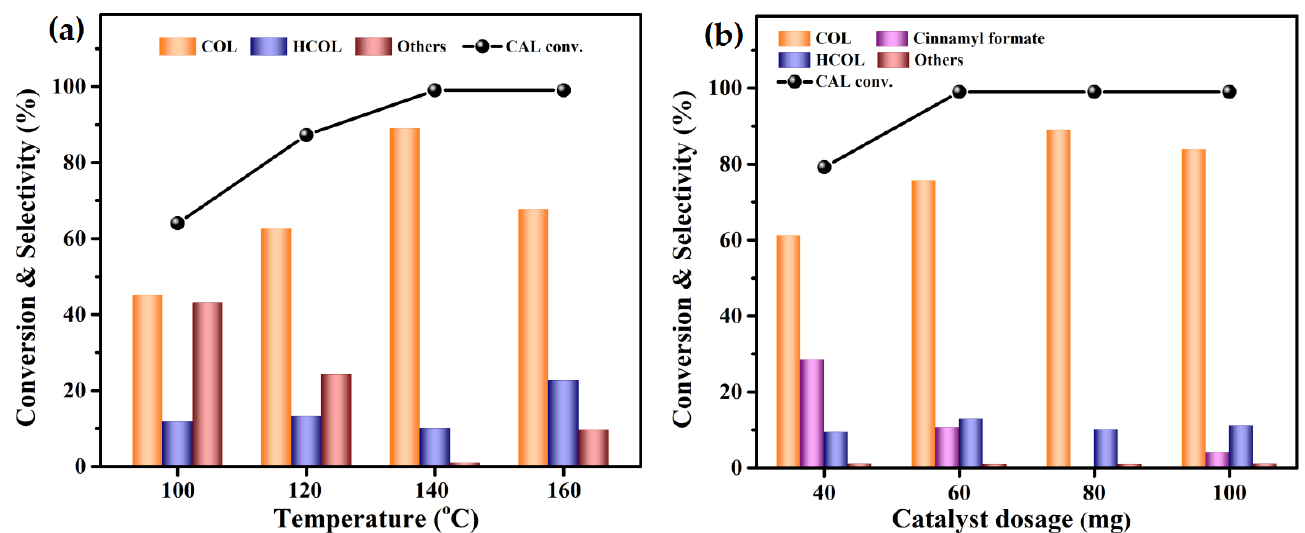
Figure 4. Effect of ( a ) reaction temperature; ( b ) Co 1 Re 1 /TiO 2 catalyst dosage for the hydrogenation of CAL to COL. Reaction conditions: 3 mmol CAL, CAL:FA:NEt 3 = 1:2:2, 10 mL THF, 80 mg Co 1 Re 1 /TiO 2 catalyst, 140 °C, 4 h. Others: allylbenzene, isopropenylbenzene, 1,1 ′ -(1,5-hexadiene-1,6- diyl)bisbenzene and other unknown by-products.